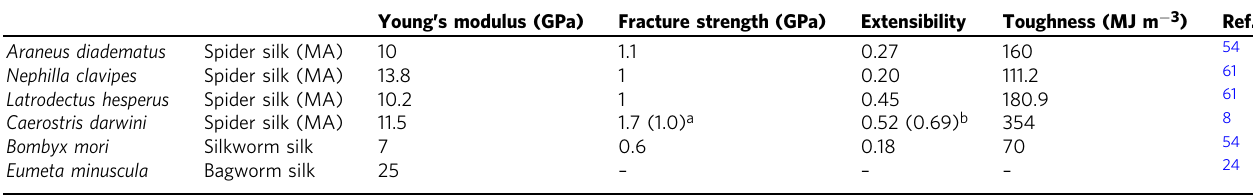
Table 1 Tensile properties of various silks